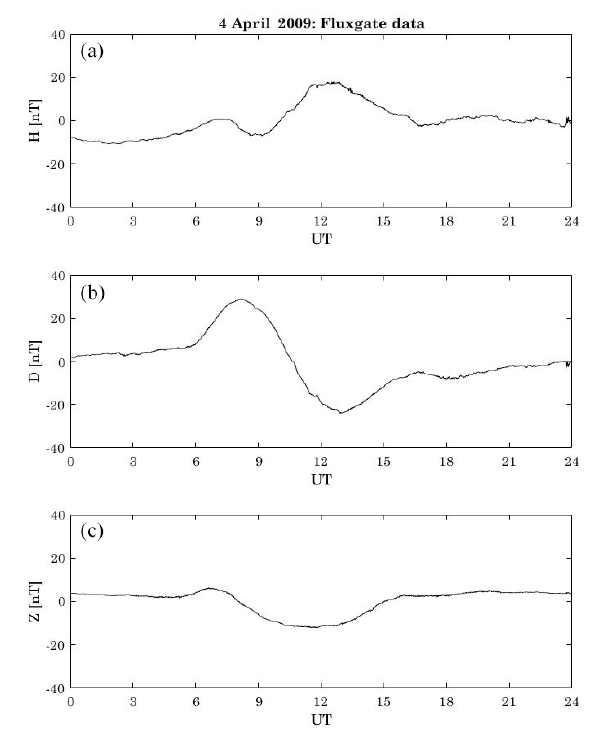
Figure 7. Geomagnetic field observations at L’Aquila ground sta- tion: (a) shows the H (north–south) component; (b) shows the D (east–west) component; (c) shows the Z (vertical) component. The observations show the typical Sq daily